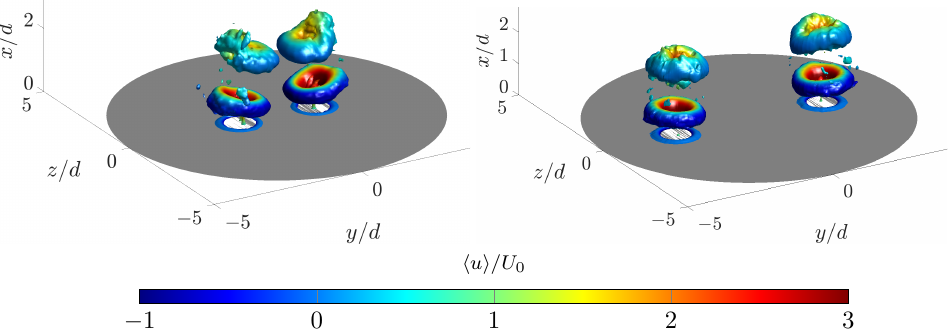
Figure 10. Isosurfaces of phase-averaged Q-criterion, colored with the streamwise phase-averaged velocity component